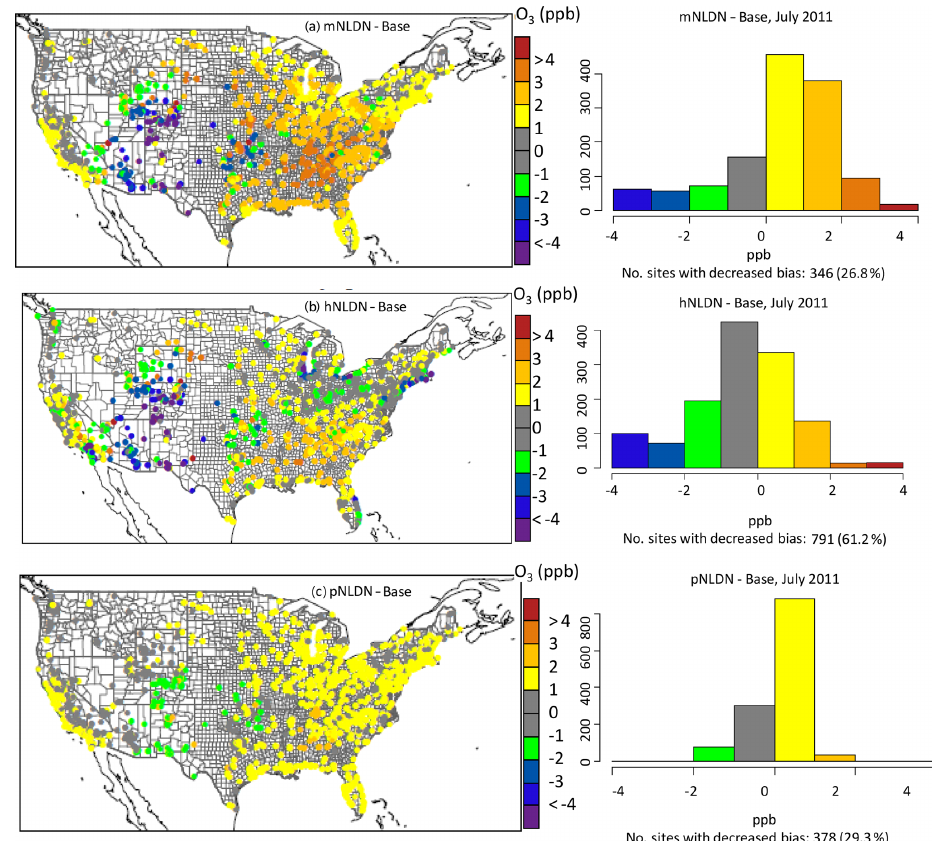
Figure 5. Spatial maps of the mean bias of DM8HR O 3 (model – observation) differences between model case with LNO x and the Base as well as the corresponding histograms indicating the number of sites with decreased mean bias for each pair of model cases in July 2011.